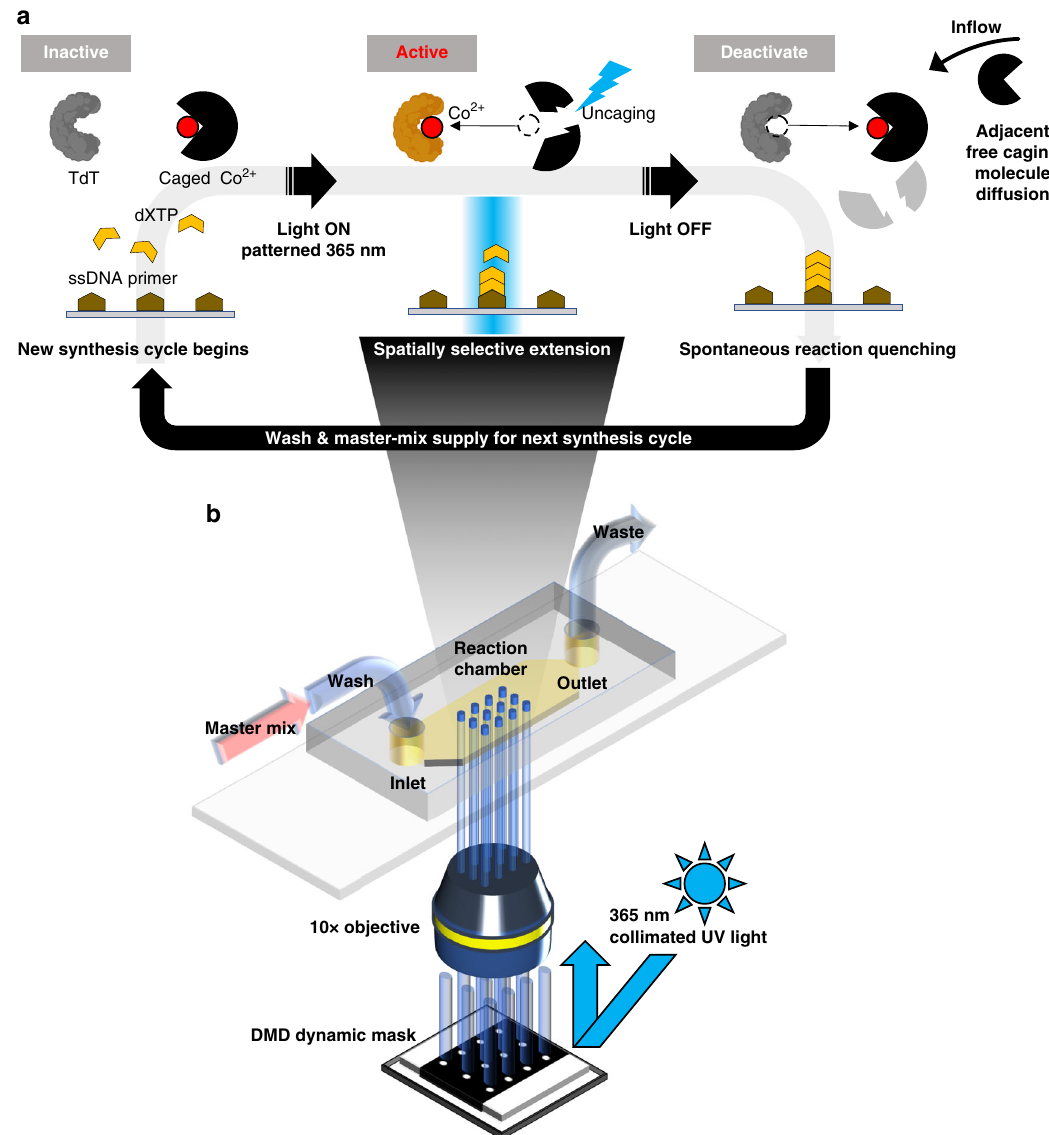
Fig. 1 Overview of photon-directed multiplexed enzymatic DNA synthesis system. a An array surface derivatized with single-stranded DNA initiator oligonucleotide is brought into contact with a master mix containing the appropriate buffers, Co 2 + divalent cation cofactor, TdT enzyme, the desired nucleotide to be incorporated (dXTP), and photolabile DMNP-EDTA caging molecule provided in excess. All Co 2 + ions are initially complexed with DMNP- EDTA, which causes TdT to remain in an inactive state until needed. Using photolithography, patterned UV light at 365 nm illuminates the array ’ s surface causing the complexed DMNP-EDTA to degrade releasing Co 2 + ions and activates TdT in a spatially selective manner. The UV light is then turned off and the reaction is allowed to incubate for a short period of time. During this incubation, excess, non-complexed DMNP-EDTA spontaneously quenches the extension reaction by chelating free Co 2 + causing active TdT to become inactive. The array surface is then washed and either the next synthesis cycle begins or material is retrieved from the surface for downstream applications. b Arrays are mounted into a simple fl ow cell with a reaction chamber inlet